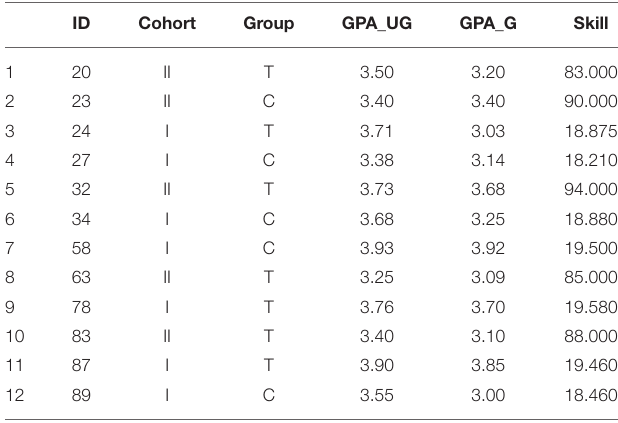
TABLE 1 | Demographic data pertaining to students non-compliant with study